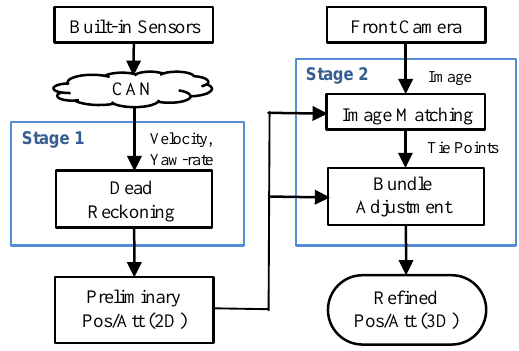
Figure 1. Overview of